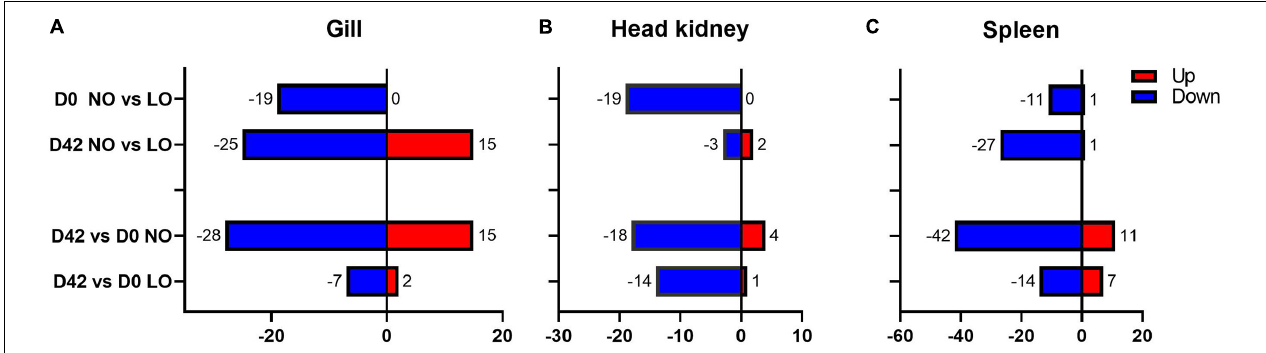
FIGURE 2 | Gene expression in the beginning and end of light stimulation of smoltification analyzed with a multigene Biomark HD assay including 92 immune and stress genes (ImCom). Numbers of genes with expression differences between the time-points (days 42 and 0) and the treatment groups in gill (A) , head kidney (B) , and spleen (C) . NO, LO – groups maintained at normal and low dissolved oxygen.